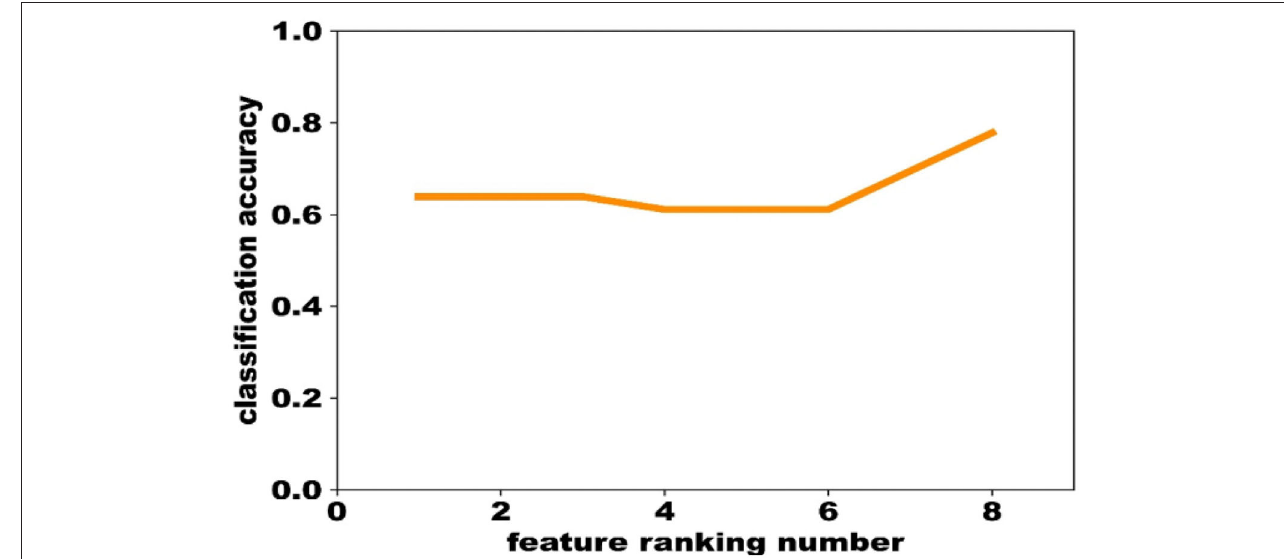
FIGURE 2 | The procedure of feature selection on the evaluation data.